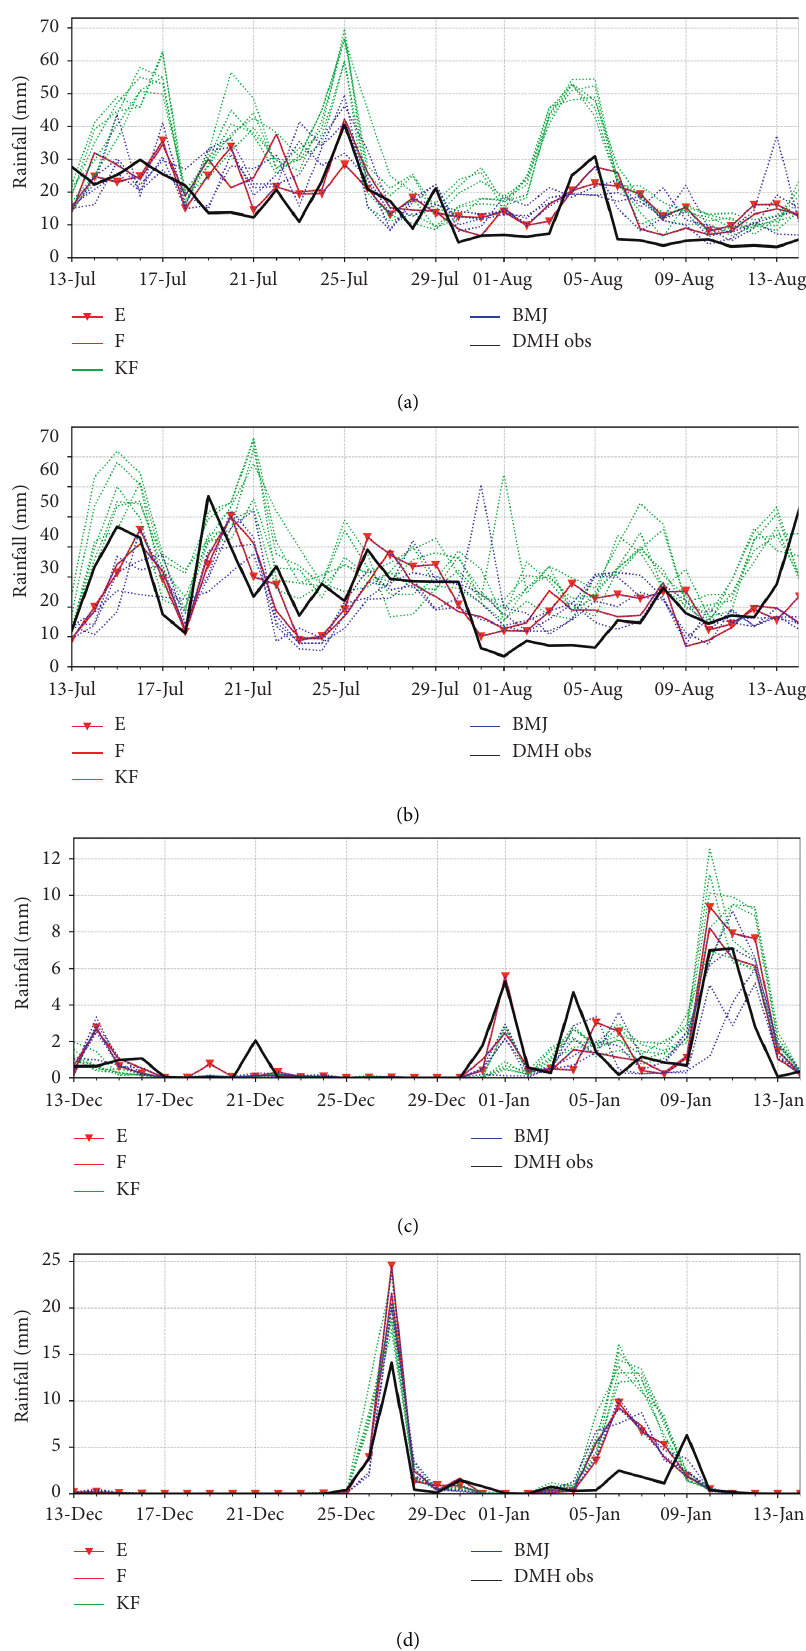
Figure 3: Time series plots of daily average rainfall for Lao PDR, highlighting the CU physics option. Simulation with the KF scheme is given in green and that with the BMJ scheme in blue. (a) Wet season 2017, (b) wet season 2018, (c) dry season 2017, and (d) dry season